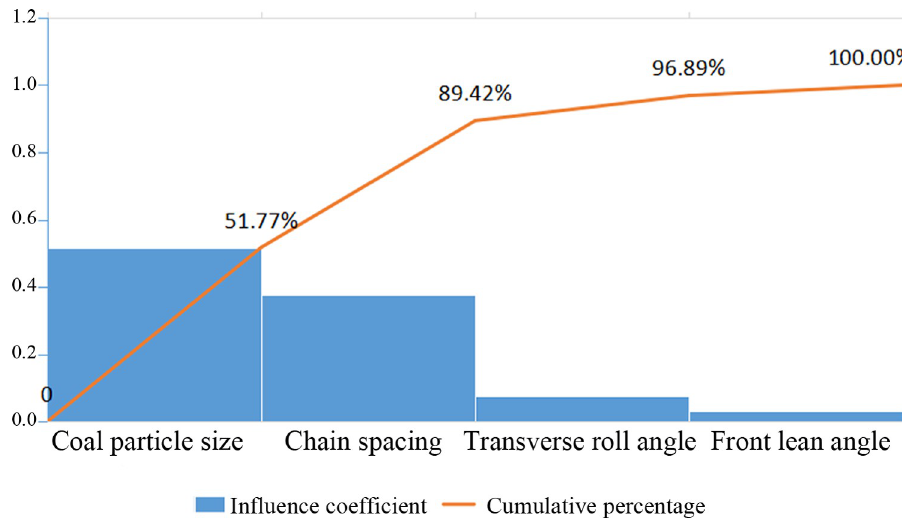
Fig 14. Pareto diagram of the impact damage factors of the middle